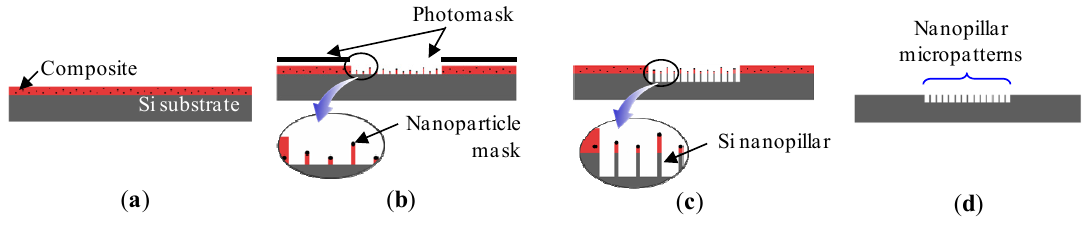
Figure 2. Concept and demonstration of hybrid mask lithography: ( a ) spin coating of composite; ( b ) patterning of composite; ( c ) deep reactive ion etching (DRIE); and ( d ) removal of composite.